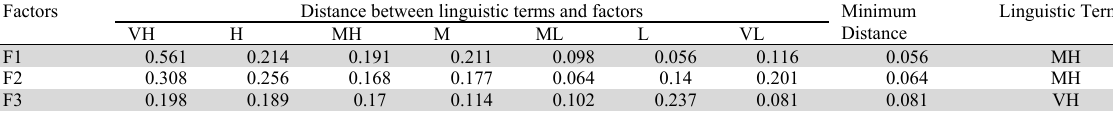
The linguistic terms correlate with the average fuzzy scores for the technological factors Factors Distance between linguistic terms and factors